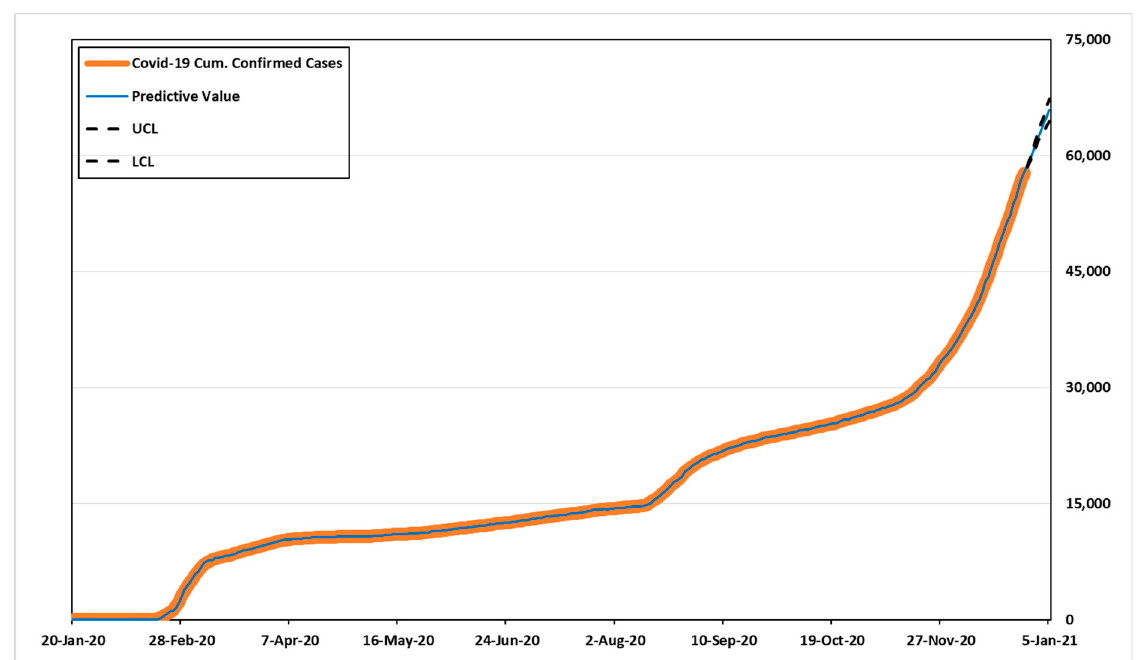
Figure 4. Time ‐ series plot for the best ARIMA (1,2,5). 4. Discussion In Section 3, we used ARIMA to compare the criteria of each case using data sets from Korea. The period between 20 January to 26 October 2020 was divided into five based on (1) peak of the first wave; (2) the day when the increase in confirmed cases is at its mini ‐ mum; (3) the day when the variability of the confirmed case is high before the peak of the second wave; (4) peak of the second wave; and (5) the day when the variability of the confirmed cases is high before the peak of the third wave. Tables 3–7 show the top six results by comparing the goodness ‐ of ‐ fit of the ARIMA model for each group and case, and Table 8 shows the top five results based on SSE to examine the predicted values.